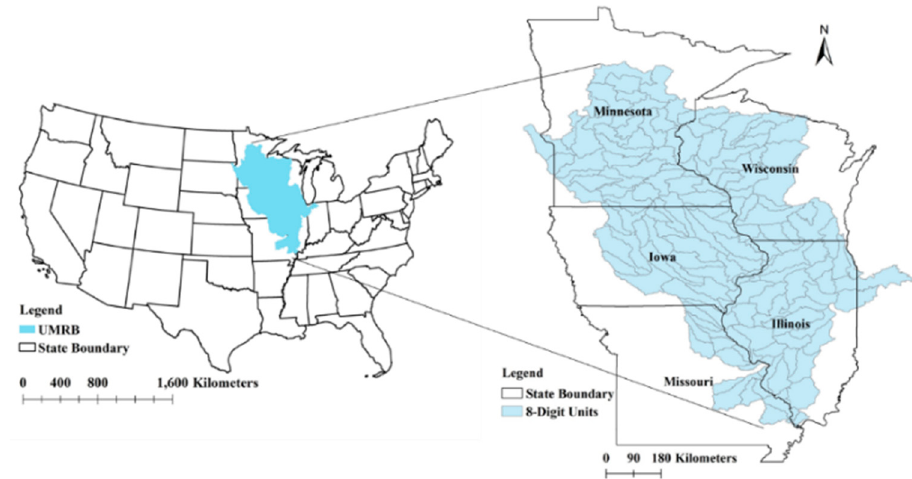
Figure 1. Location of the Upper Mississippi River Basin (UMRB) with eight-digit hydrologic unit codes (HUCs) and state boundaries.